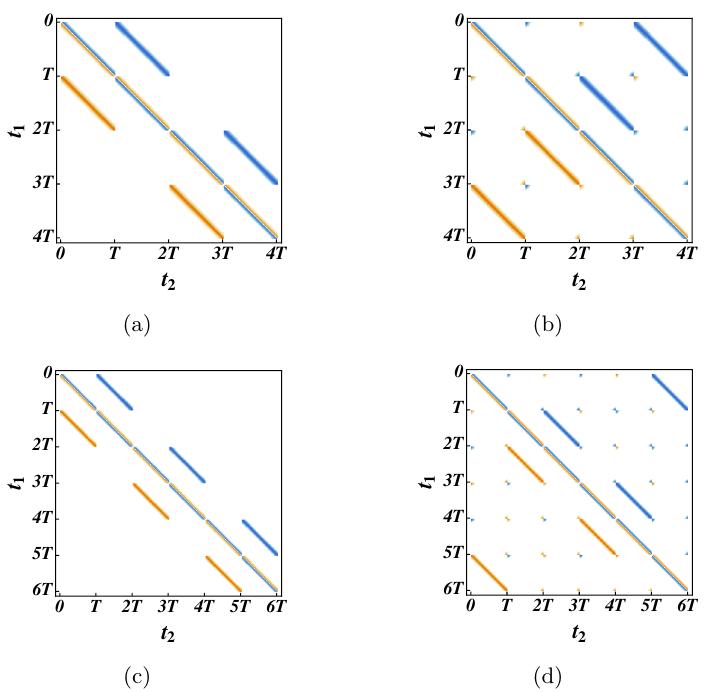
Figure 2 . The numerical replica diagonal and non-diagonal solutions for n = 2 (a,b), and for n = 3 (c,d). The coordinates are arranged such that (2 kT; (2 k + 2) T ) belongs to the k -th replica, and within each replica, (2 kT; (2 k + 1) T ) [((2 k + 1) T; (2 k + 2) T )] is the forward s = + (backward s = (cid:0) ) contour. Small nonvanishing values appear at the locations of the twist operators. This has important contributions to the onshell action, and we discuss it in appendix